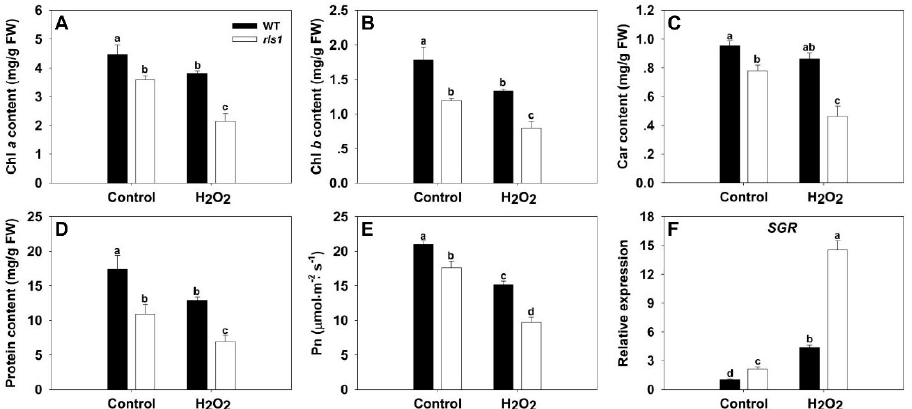
Figure 6. The physiological effect of oxidative stress on WT and rls1 plants. ( A – C ) The content of photosynthetic pigments in the full expanded leaf: ( A ) chlorophyll a ; ( B ) chlorophyll b ; ( C ) carotenoid; ( D ) protein content; ( E ) the net photosynthetic rate of the leaf; ( F ) the abundance of SGR (senescence-induced STAY GREEN) transcript. For normalization purposes, the transcript abundance of SGR in non-stressed WT was set to 1. Values expressed in the form mean ± SE (( A – E ): n = 5, F: n = 3). Significant differences between means ( p < 0.05) indicated by different letters. FW: fresh